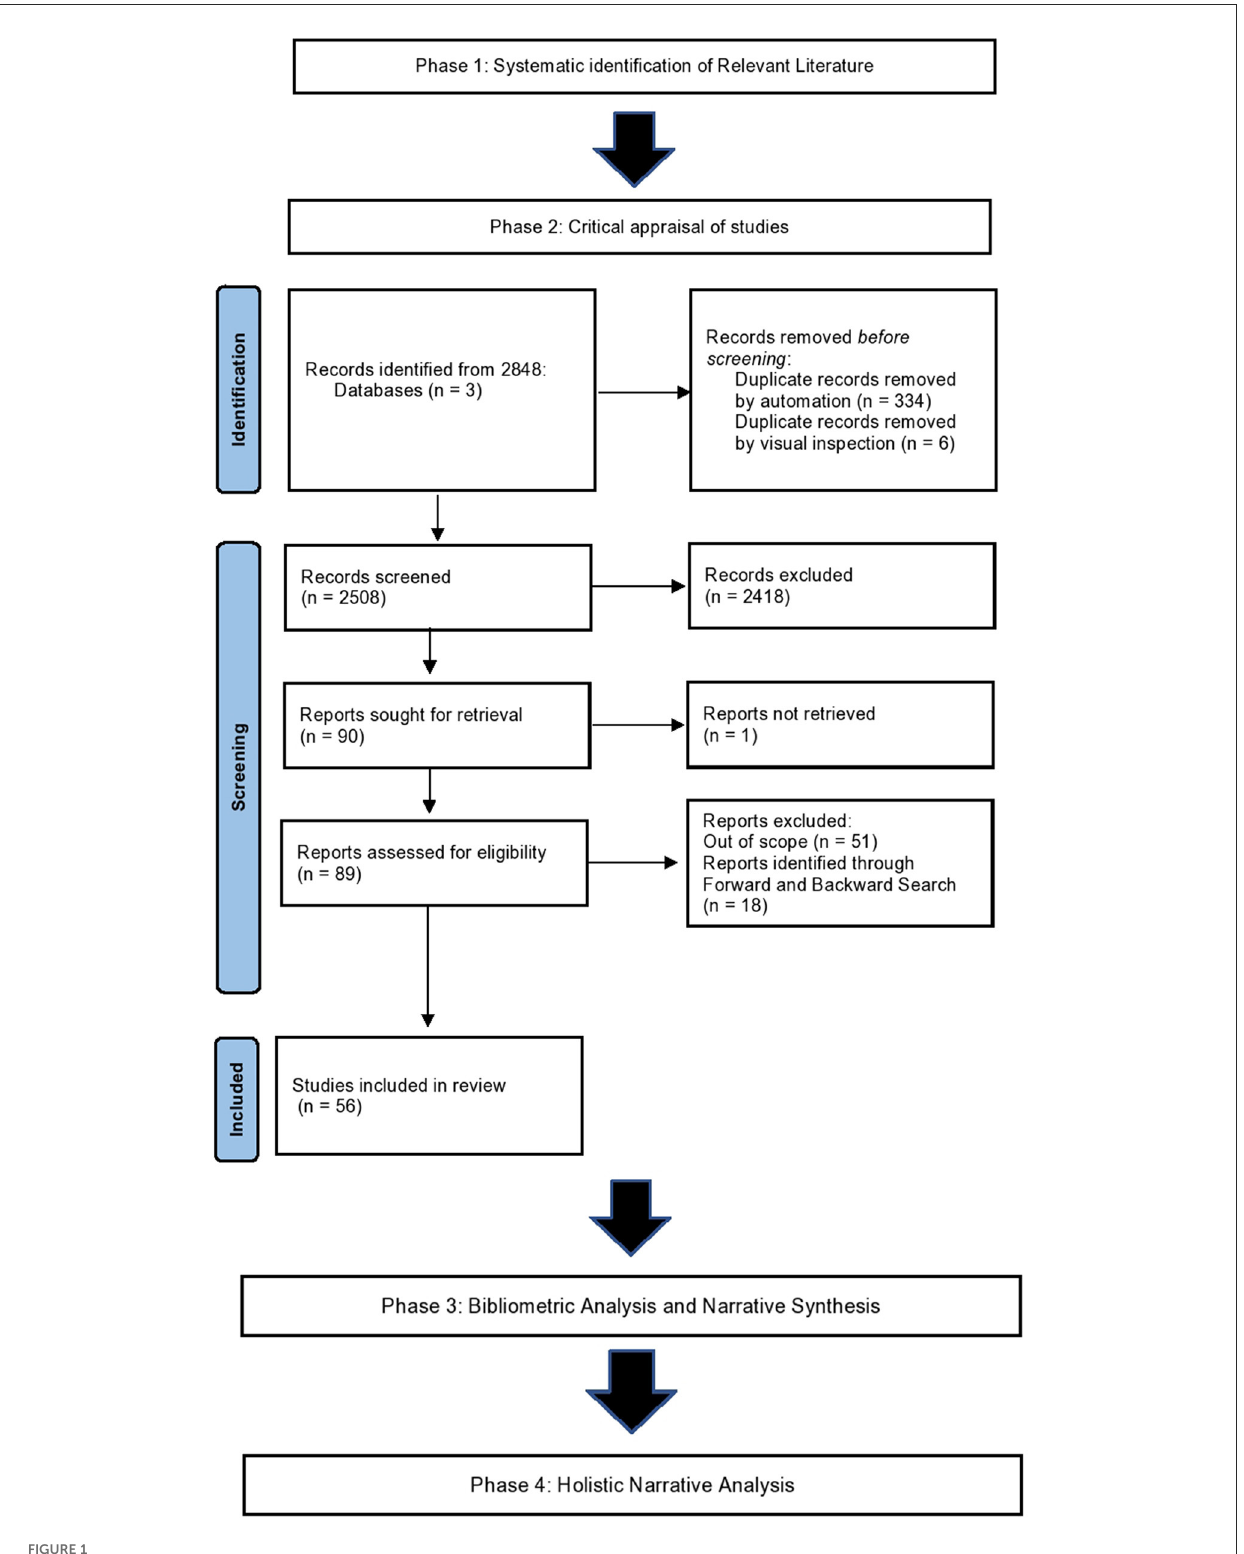
FIGURE1 PRISMA criteria described by Page et al. (2021). The PRISMA 2020 statement: an updated guideline for reporting systematic reviews.